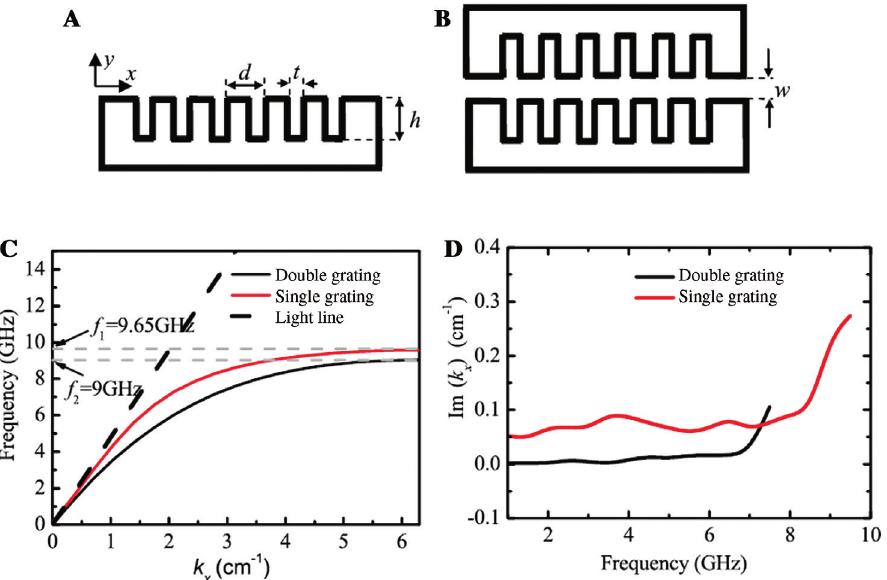
Figure 4: Schematic pictures of single and double ultrathin corrugated metal plates and their dispersion curves. (A, B) Single and double corrugated metal plates, respectively, in which the groove depth, width, and periodicity are designed as h , t , and d , respectively. The gap between the double corrugated metal plates is denoted as w . The parameters h , t , d , and w are defined as 6.5 mm, 1 mm, 5 mm, and 1.5 mm, respectively. (C) Dispersion curves of single and double gratings, in which the red and black solid lines correspond to the single and double gratings, respectively, and the black dashed line denotes the light line in free space. (D) Im( k ) as a function of frequencies for double and x single grating. Reproduced from [41] with